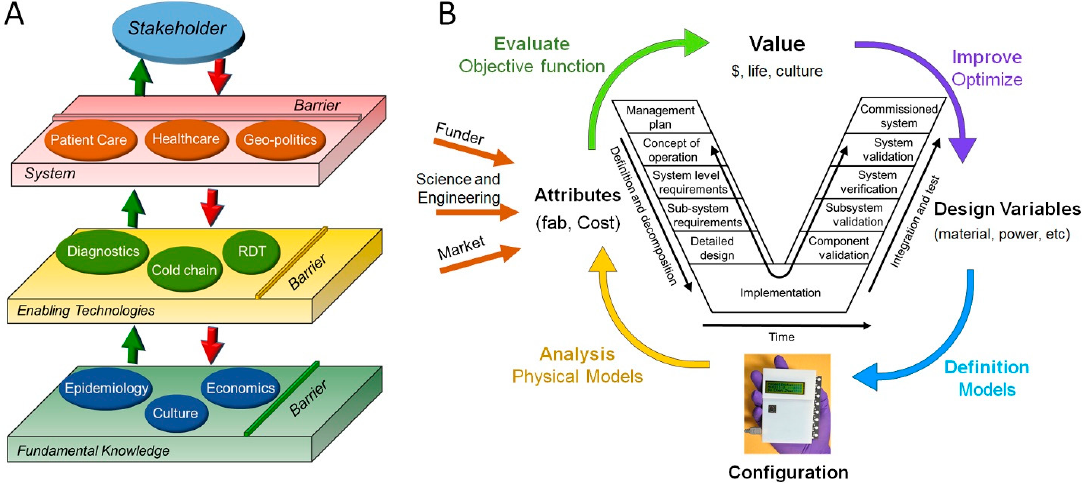
Figure 1 . An expanded view of the challenges and approaches to effective design of affordable RDTs. ( A ) Three tier schematic diagram of the different critical levels in the design process with their associated barriers. Tier 1 captures all fundamental knowledge associated with diagnostics and healthcare, while Tier 2 is the enabling technologies that are then translated to Tier 3 here capturing the local health care system and associated socio-cultural structures. All three tiers make the overall system. ( B ) Systems engineering approach to design of low-cost RDTs with the capture capturing the underlying V-model but specifically focusing on value addition where “value” is dictated by each stakeholder but with the end-user definition carrying a higher weight. Attributes are derived from the stakeholders and the drivers of the design and fabrication (abbreviated “fab”) and cost. The existence of feedback loops during the design process allows for efficiency and appropriateness in the design, production and adoption of the product.